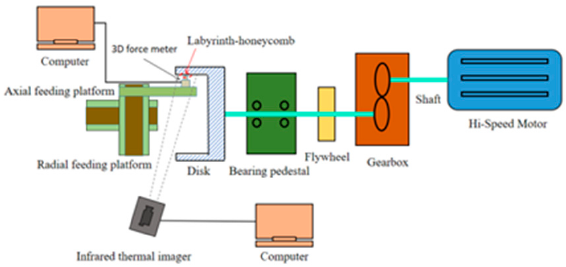
Figure 2. High-speed rotary rubbing test system.